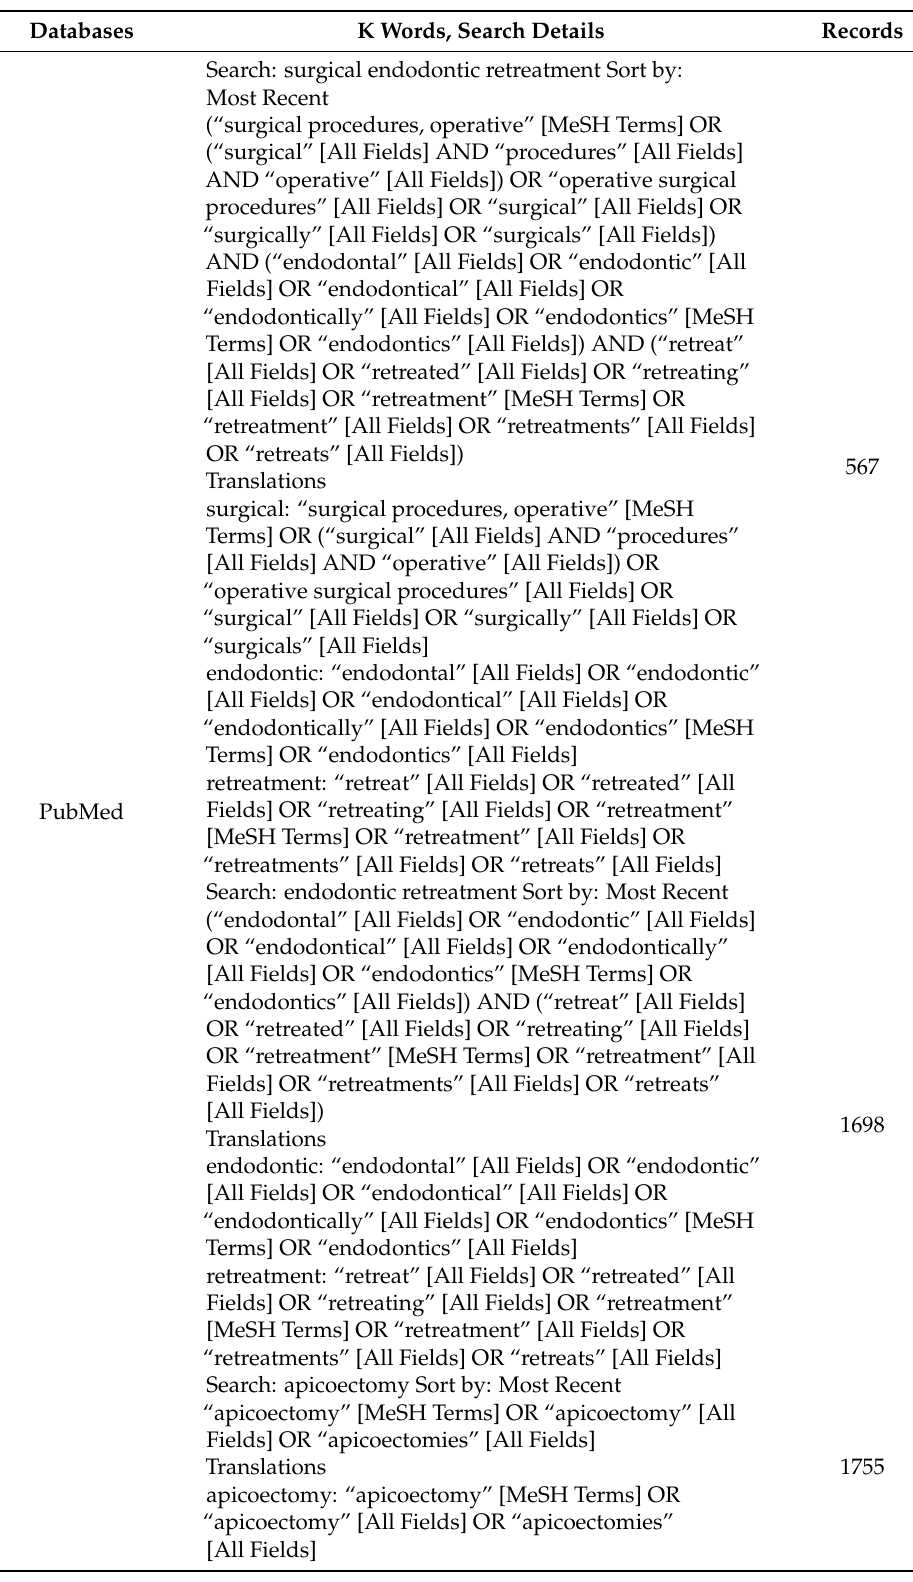
Table 1. Complete overview of the search